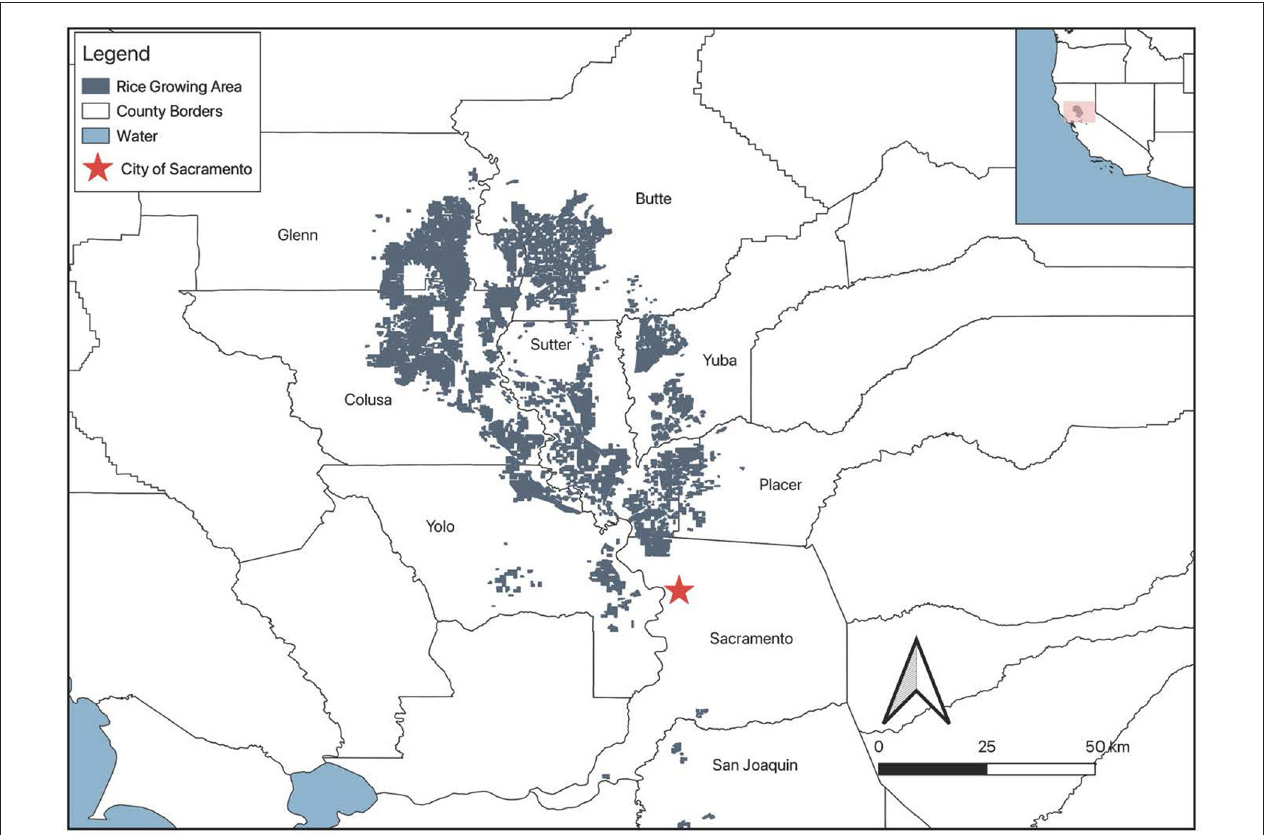
FIGURE 1 | Map of rice growing areas in the Sacramento Valley of northern California, USA. Counties where grower interviews took place include (from northeast to southeast) Glenn, Butte, Colusa, Yuba, Sutter, Placer, Yolo, Sacramento, and San Joaquin. Map created by Luke Salvato. Data Source: USDA National Agricultural Statistics Service Cropland Data Layer. (2021). Published crop-specific data layer.